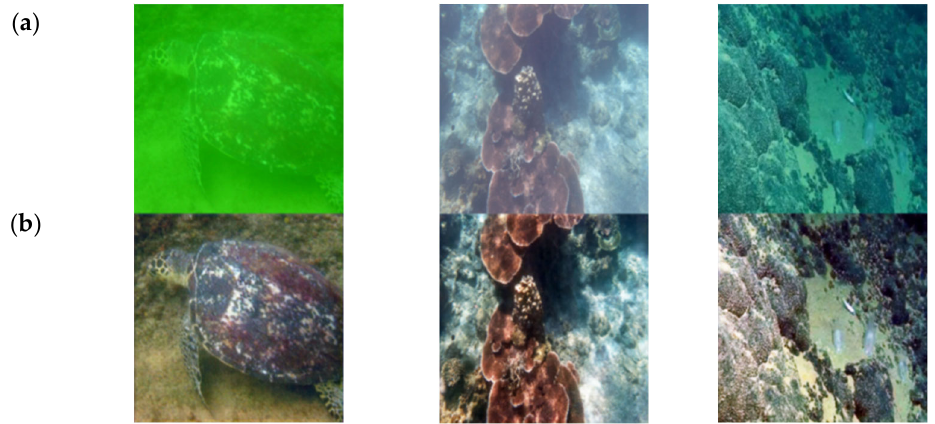
Figure 1. Example of underwater image. From top to bottom are ( a , b ). ( a ) Original image and ( b ) enhanced image by our method.